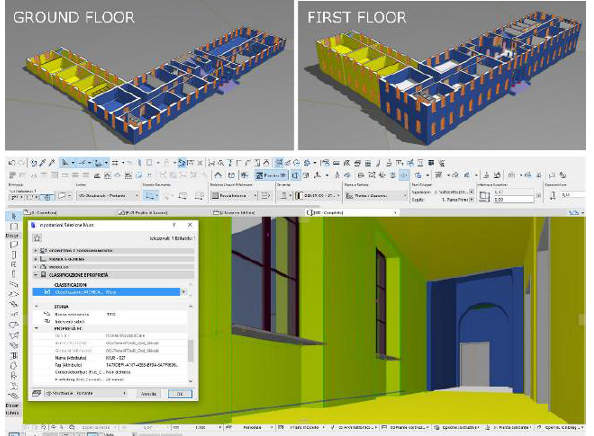
Figure 10 Highlight of construction stages in ArchiCAD from a global point of view (top), and from an immersive view (bottom).